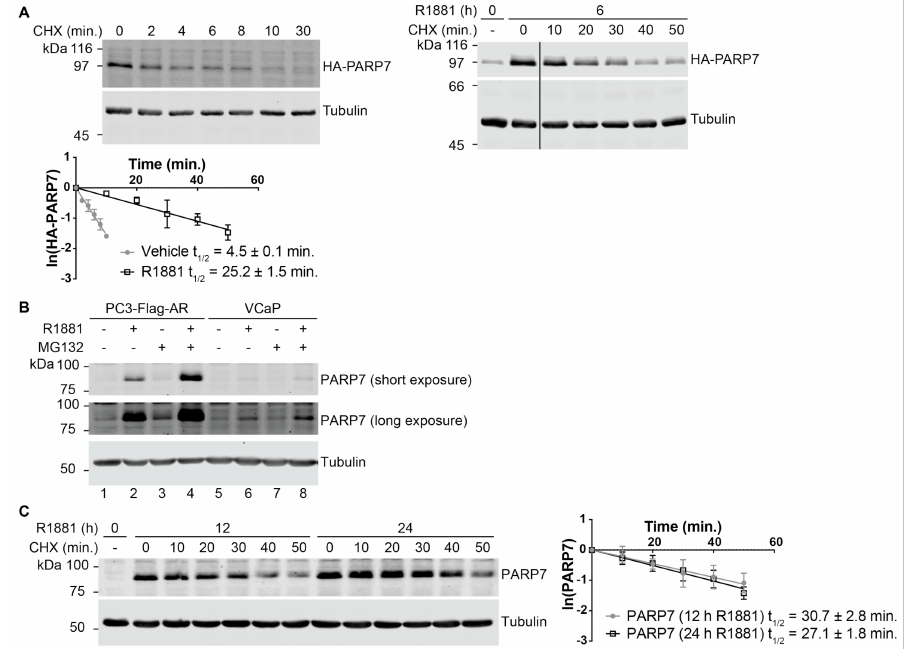
Figure 2. PARP7 undergoes very rapid protein turnover and is stabilized by AR signaling. ( A ) PC3-Flag-AR/HA-PARP7 cells were treated with 100 µ g/mL cycloheximide (CHX) for indicated